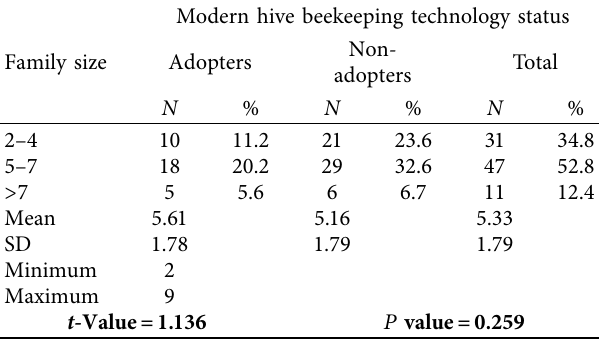
Table 5: Distribution of the family size of the household of the respondents.